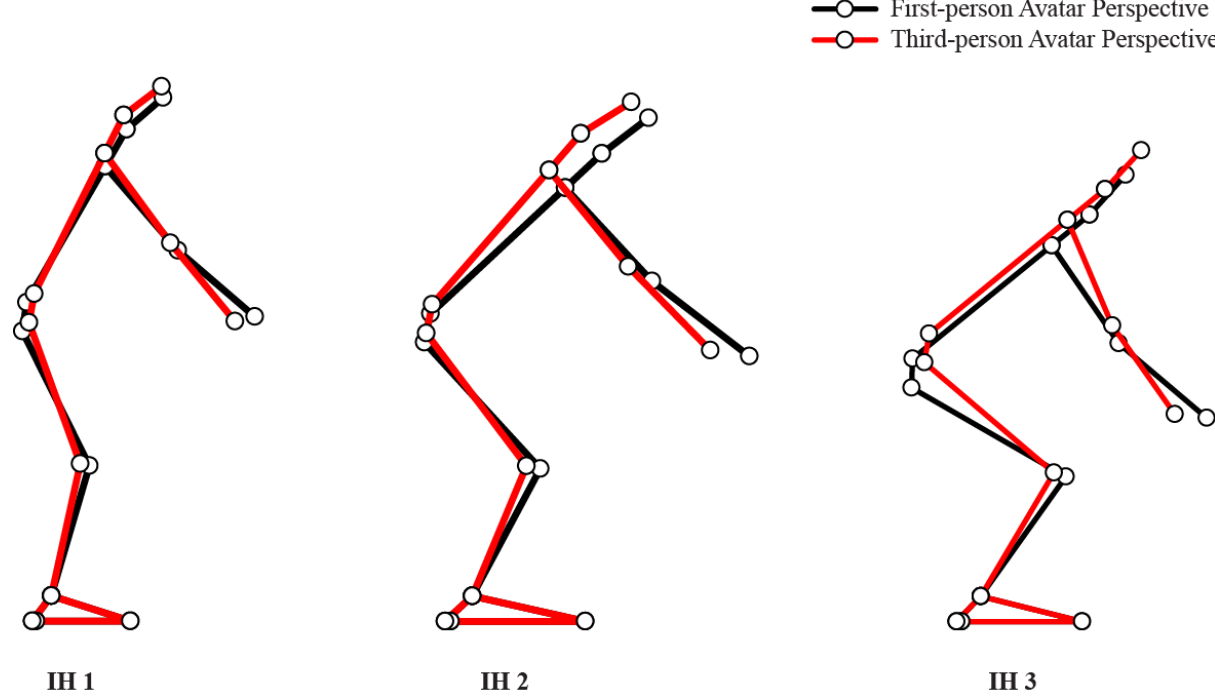
Figure 5. Average effects of first-person avatar perspective versus third-person avatar perspective for IH1 (left panel), IH2 (middle panel), and IH3 (right panel) on the posture adopted at target intercept while playing virtual dodgeball using a head-mounted